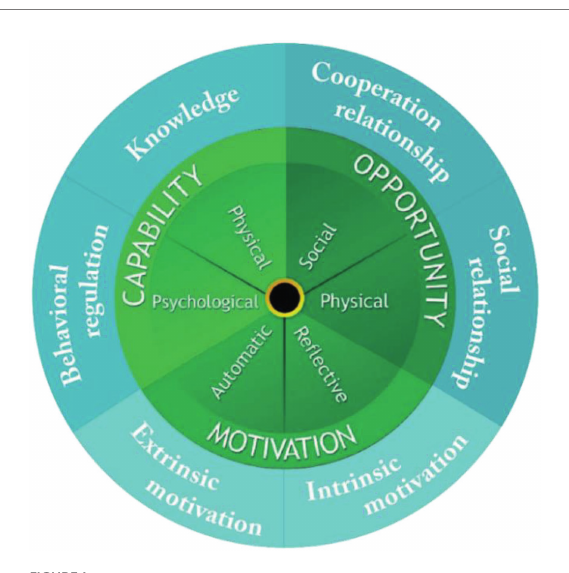
FIGURE 1 Map of the theoretical domains framework (TDF) to sources of behavior on the COM-B system.